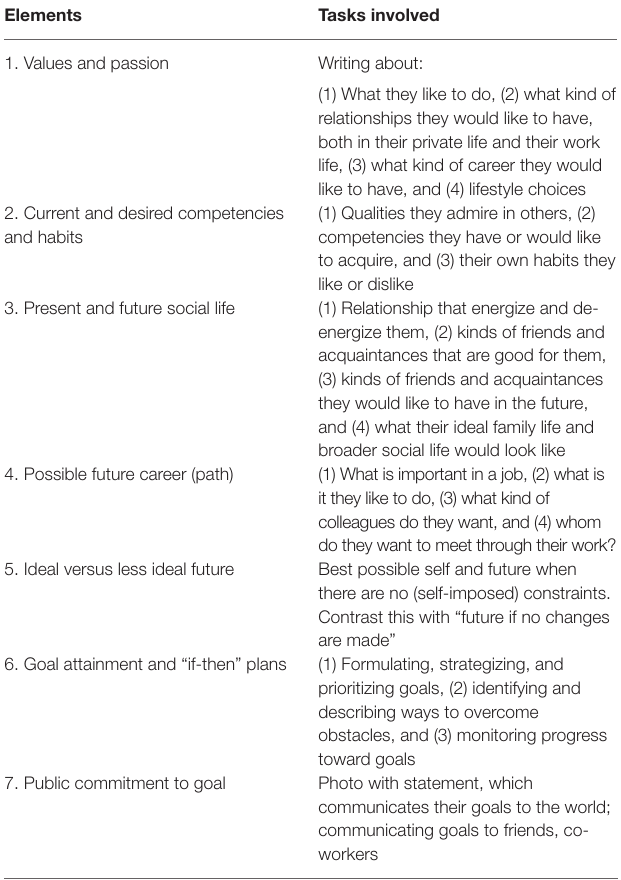
TABLE 1 | Elements and description of a life-crafting intervention. Elements Tasks